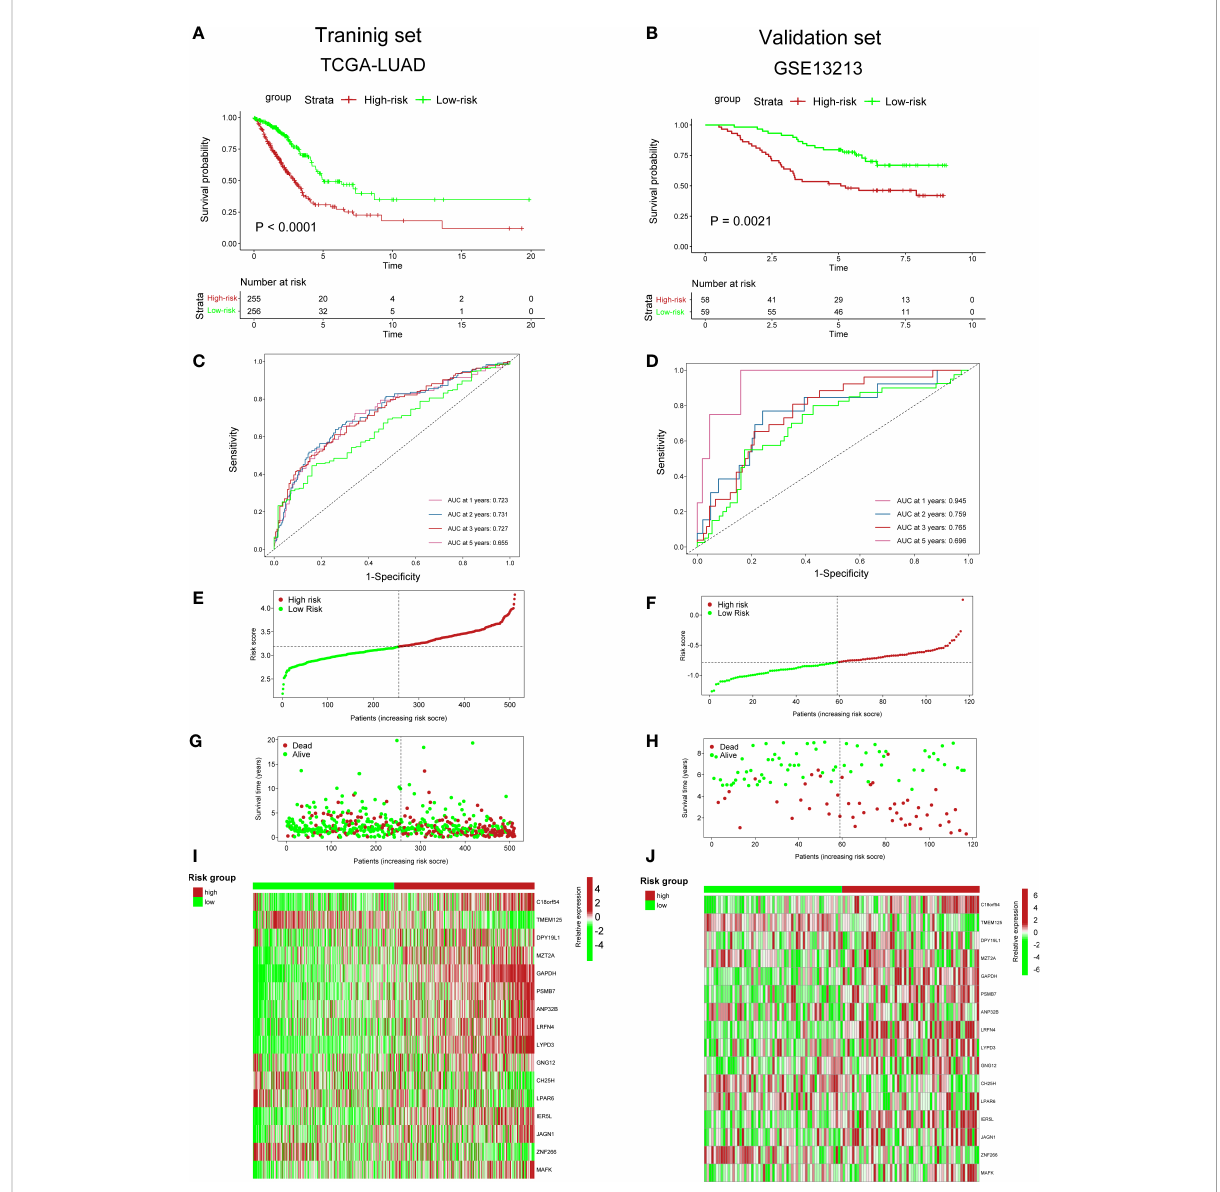
FIGURE 5 Predictive ability of cuproptosis-associated risk score for prognosis. (A, B) K – M survival curves. P value was determined by the log-rank test. (C, D) ROC curves show AUC values of risk_score. (E, F) Distribution plot shows risk_score. (G, H) Distribution plot shows the correlation between risk_score and patients ’ survival status. (I, J) The heatmap plot shows the expression of 36 genes in high- and low-risk